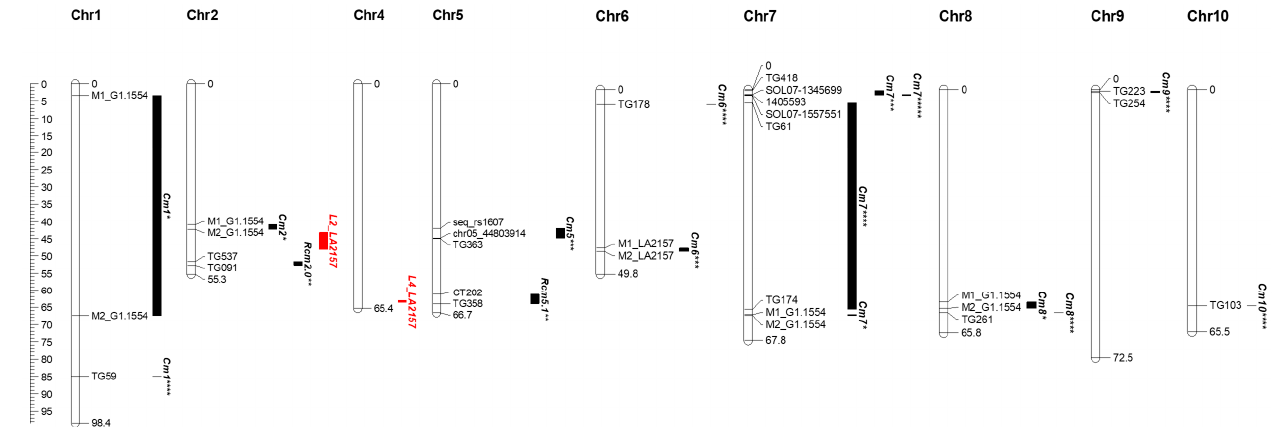
Figure 6. Overview of mapped QTLs reported to be linked to tolerance to Cm . Physical positions (Mb) of previously described QTLs linked to tolerance to Cm mapped on the Solanum lycopersicum genome. Bars indicate the QTL intervals determined by two flanking markers or one closely linked marker. Red bars indicate the newly mapped loci linked to tolerance on chromosomes 2 and 4 of tomato. References: ** [18], ***** [23], * [25], **** [26], *** [28]. It has long been speculated that